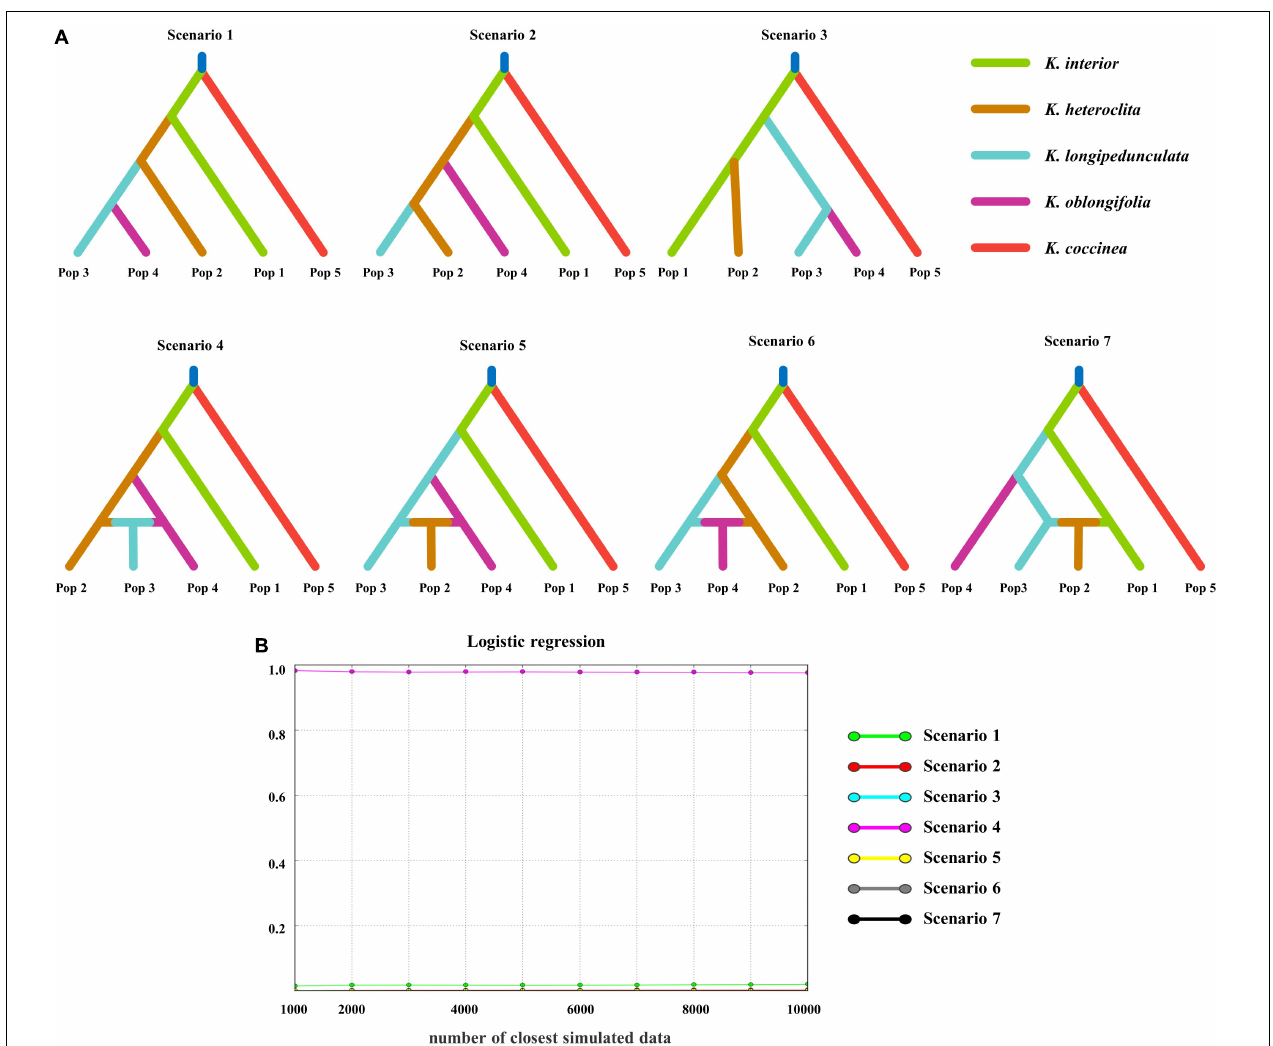
FIGURE 3 | Scenario setting and results of the DIY-ABC analysis. (A) Seven divergence scenarios for DIY-ABC analysis. The first three scenarios are without admixture and the latter four are with admixture. (B) The posterior probability of different scenarios, scenario 4 has the highest posterior probability.